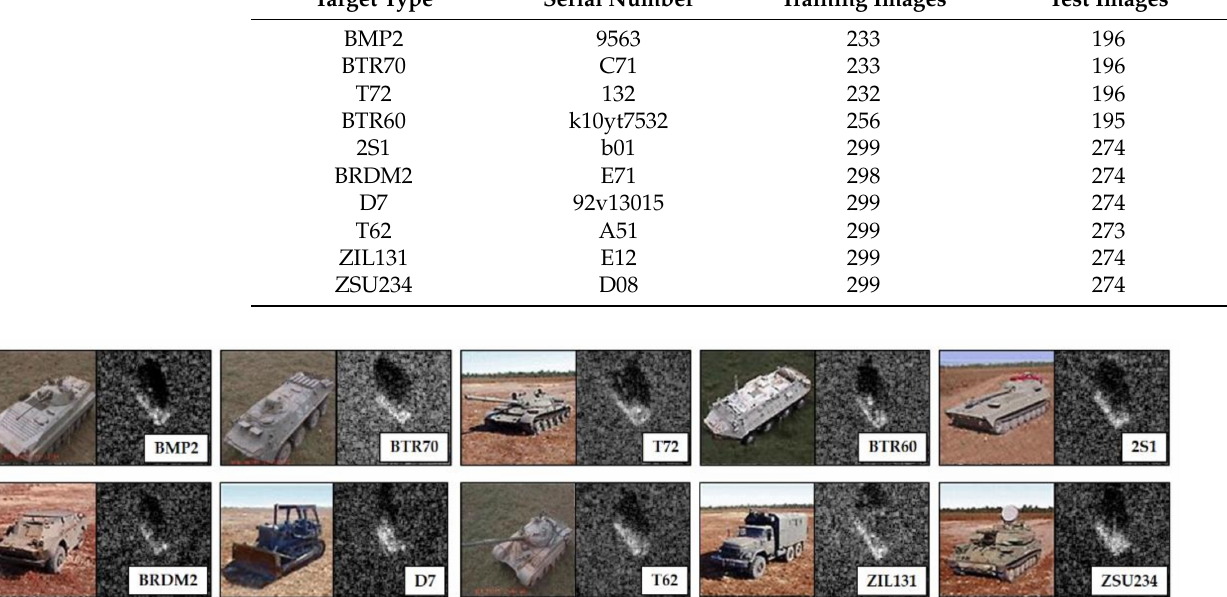
Figure 5. Optical and SAR images of 10 targets in the MSTAR